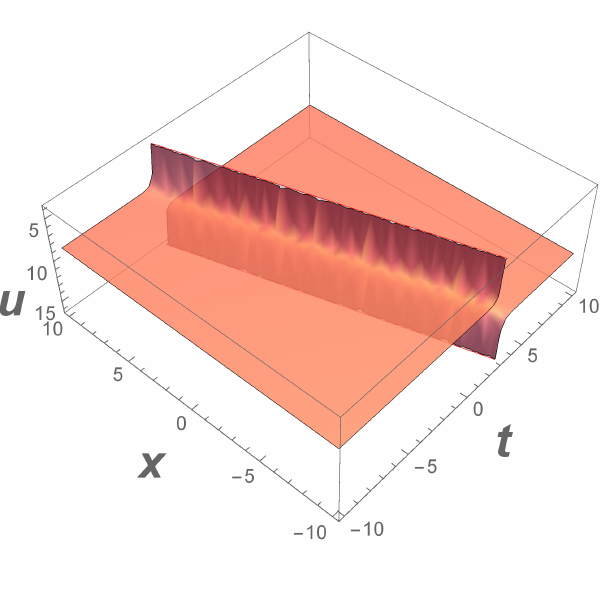
Figure 3. Evolution of the solution of (22) for case